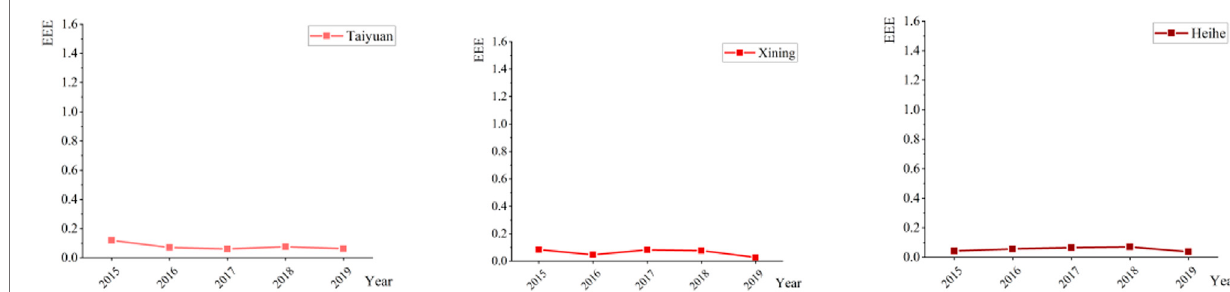
FIGURE 6 | The bottom three cities in the EEEs from 2015 to 2019.